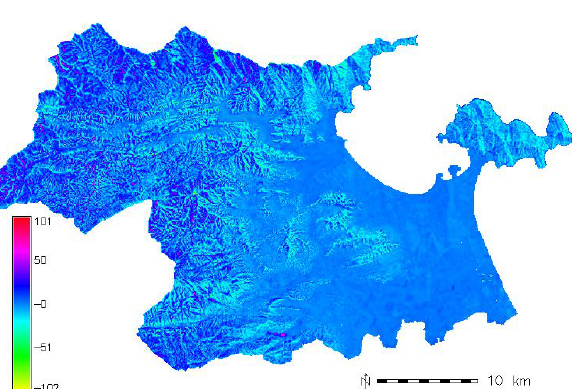
Figure 14. Difference in elevation between the fused DEM and reference